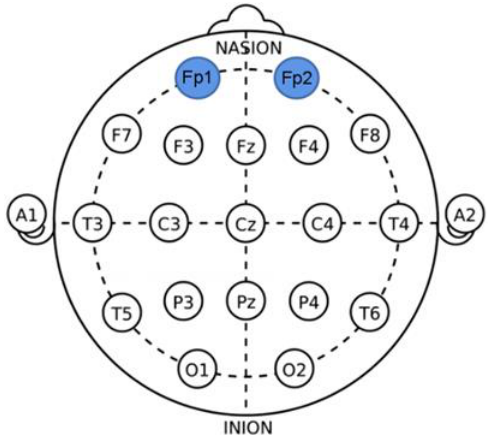
Figure 3. Electrode locations of the electroencephalography (EEG) for this experiment.